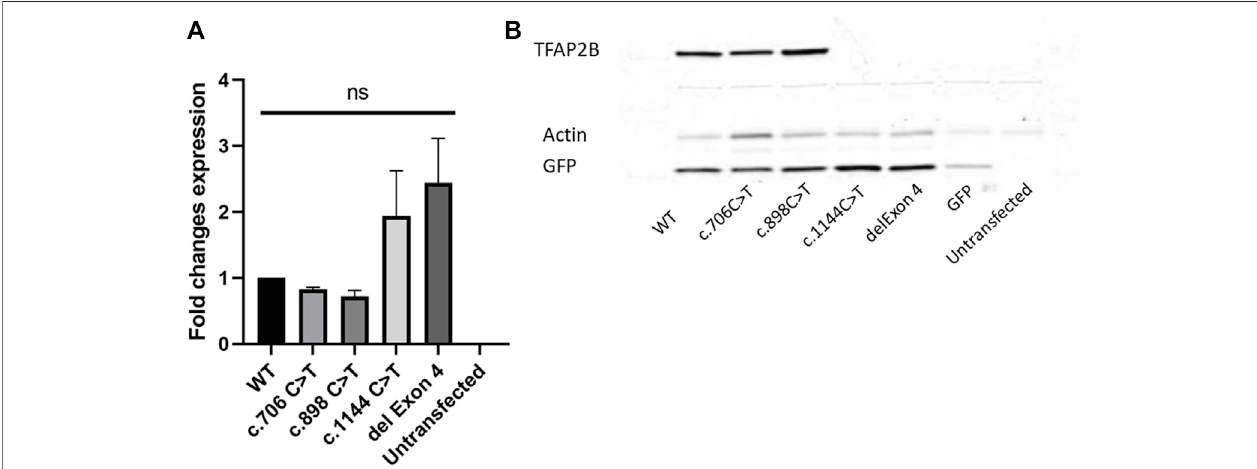
FIGURE 2| TFAP2B transcript and protein expression analysis. (A) qRT-PCR analysis of TFAP2B transcriptlevels ofWT, c.706 C > T, c.898 C > T, c.1144 C > T, andexon4deletionexpressionconstructsshownostatisticallysigni fi cantdifferenceamongthesamplesnormalizedto GAPDH and b-Actin . (B) Westernblotanalysisof all tested variants shows absence of protein products for the syndromic craniosynostosis variant (c.1144 C > T) and PIPO variant (del Exon 4). Protein products are still detectable for the Char syndrome variants (c.706 C > T and c.898 C > T). A Myc-tag antibody was used to visualize TFAP2B protein levels.